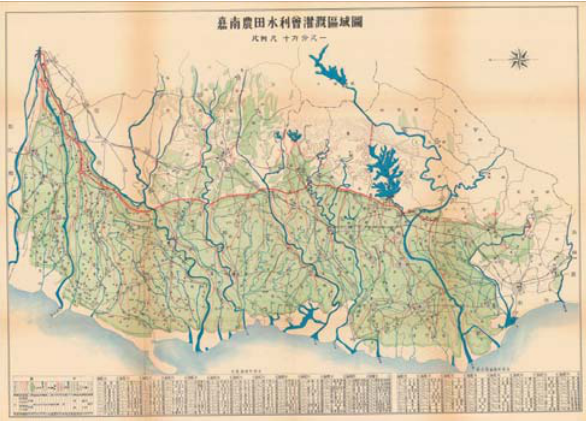
Figure 1. The Jianan Irrigation System’s operations map